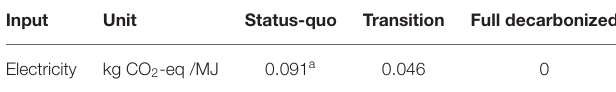
TABLE 1 | Exemplary